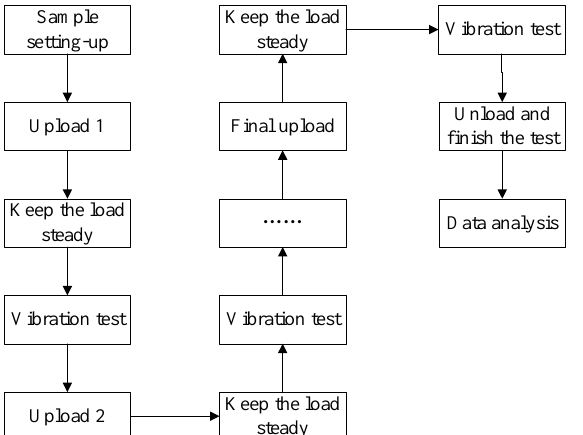
Figure 2. Test procedure of vibration frequency for prestressed steel rod-type short suspenders by using LDV.